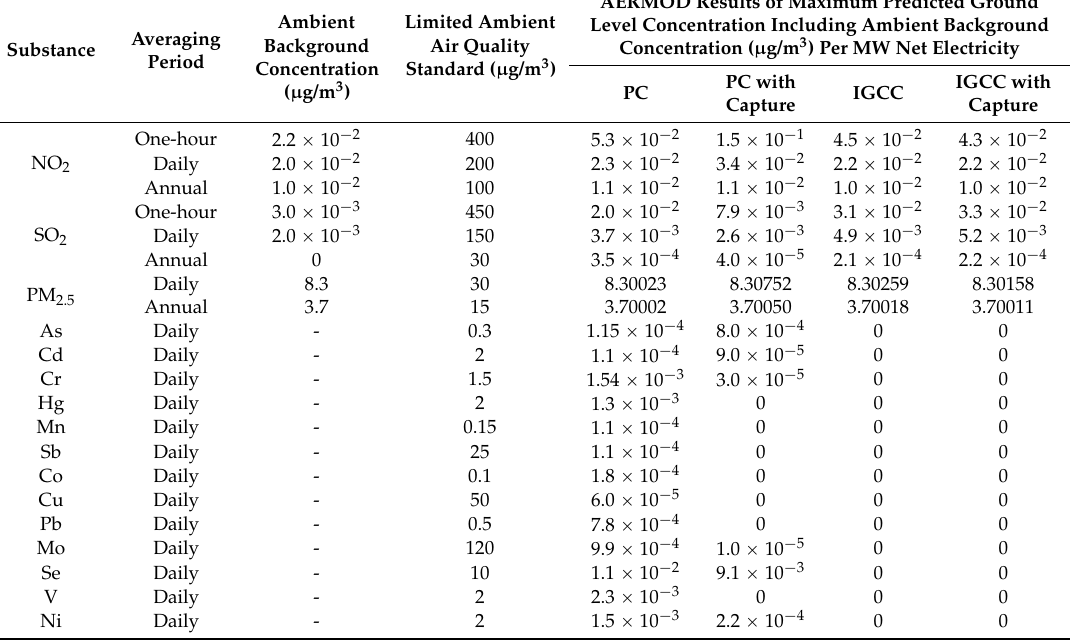
Table 9. AERMOD results: maximum predicted ground-level concentration including background concentrations per MWe